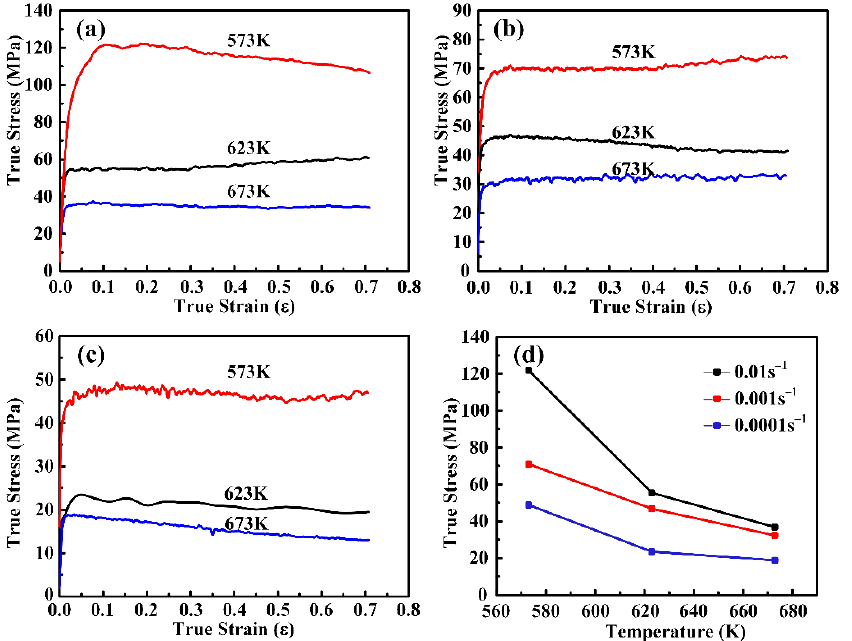
Figure 3. True stress–strain curves of as-extruded Mg–6Zn–5Ca–3Ce alloy fabricated by rapid solidification (RS) at ( a ) 0.01 s − 1 ; ( b ) 0.001 s − 1 ; ( c ) 0.0001 s − 1 and ( d ) variation of the peak stress under different deformation conditions.